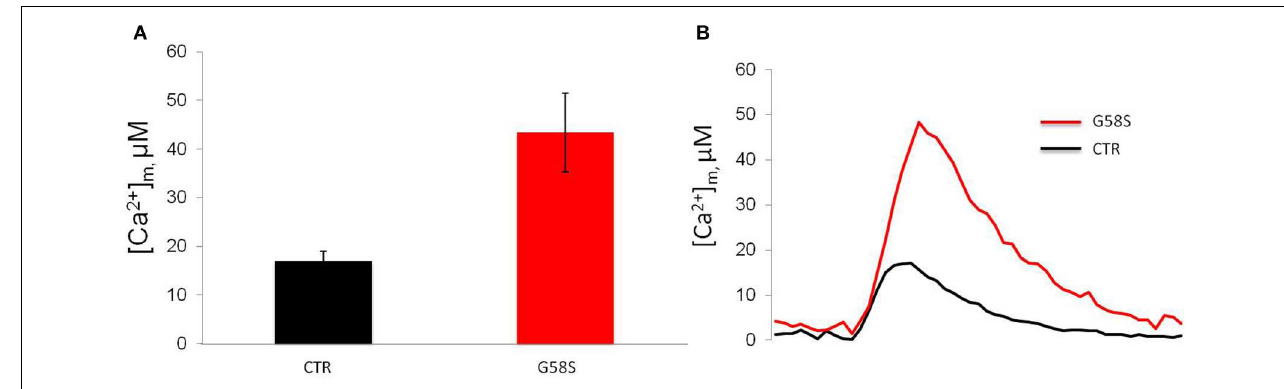
FIGURE 7 | Fibroblasts with C19orf12 mutation displayed increased Ca 2 + mobilization. (A) Mitochondrial Ca 2 + responses to agonist stimulation (100 µ M ATP) measured in human fibroblasts. Graphs show